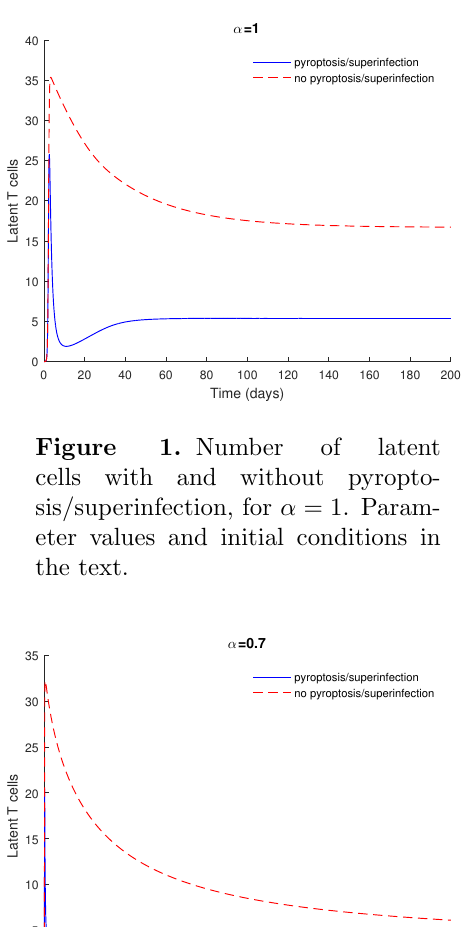
Figure 2. Number of latent cells with and without pyropto- sis/superinfection, for α = 0 . 7. Parameter values and initial condi- tions in the text.